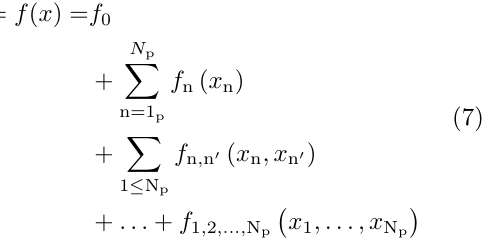
figure 5. The concrete compressive strength also ap- pears to gain in importance in the meantime before ST settles back down to the initial level. Figure 6 shows also a remarkable interaction between ρ sw and ε c2 develop in this range. This intermediate effect is due to the limiting conditions of the possible band- width of permitted compression strut angles. After exceeding the decompression stresses, small longitu- dinal strains of the same order of magnitude as ε c2 initially enter into the equations. As expected, the in- fluence of the longitudinal strain rises under increasing moment, while the shear reinforcement ratio, which is still important, decreases significantly. A moment of 0.9 MNm for the considered example cross-section (figure 2) results in the longitudinal reinforcement reaching its yield